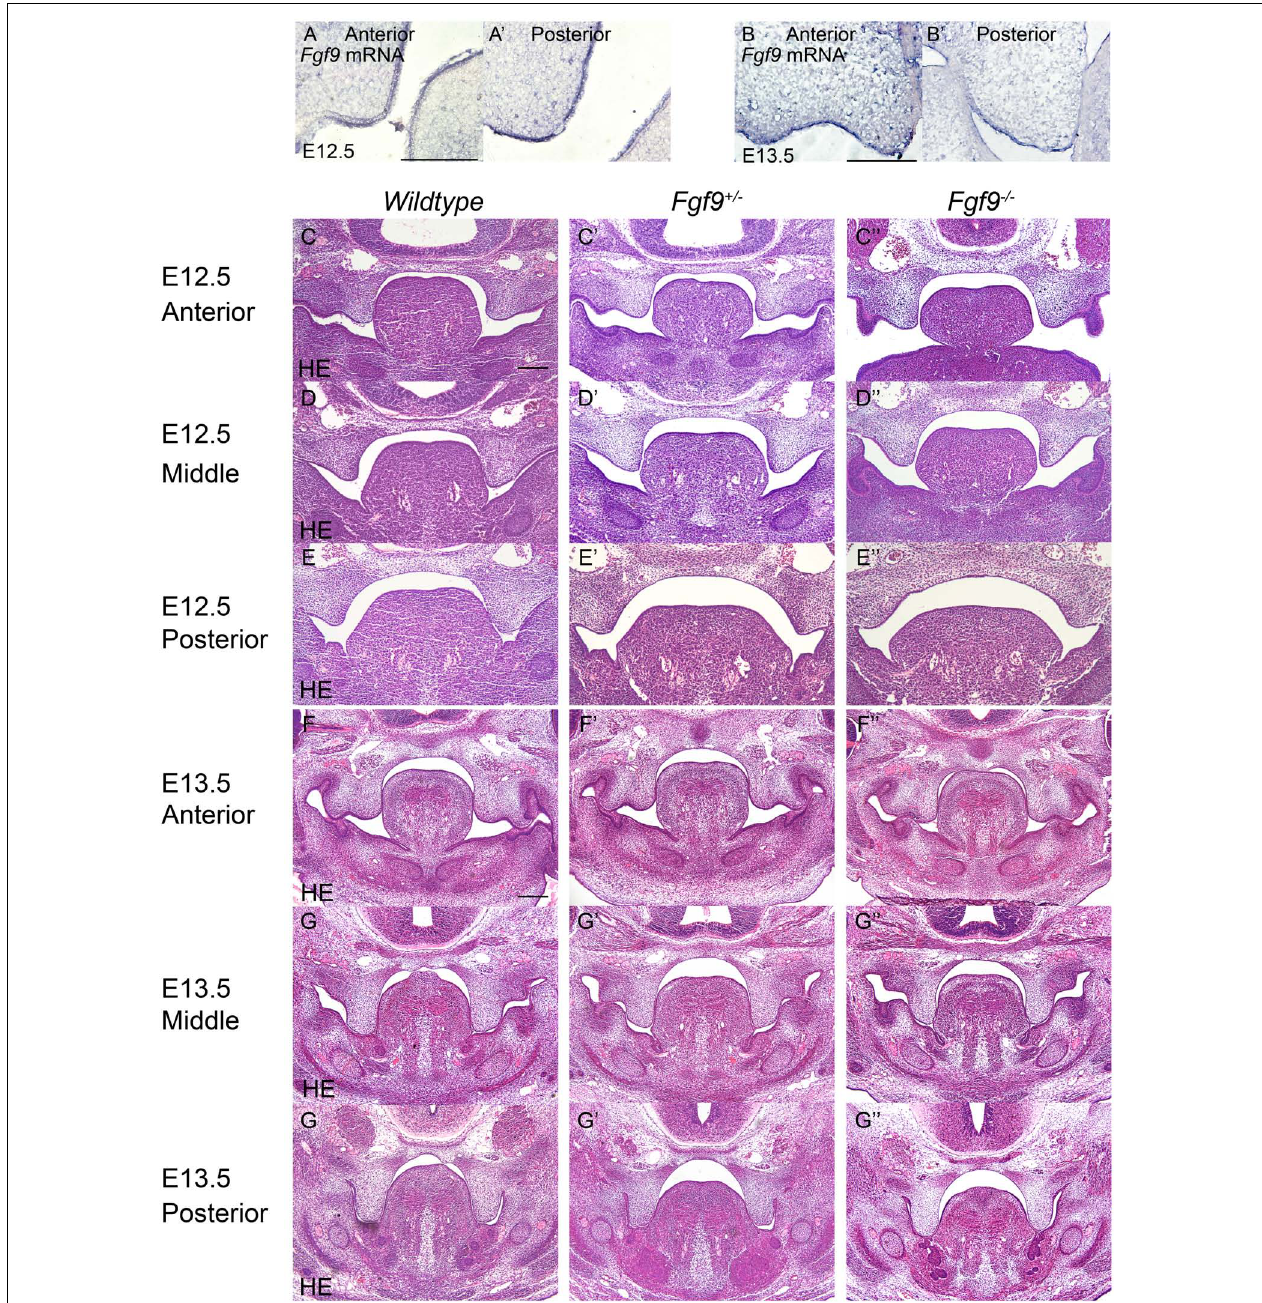
FIGURE 4 | Fgf9 expression and phenotypes of Wildtype , Fgf9 + / − , and Fgf9 − / − embryos at E12.5 and E13.5. Location of Fgf9 mRNA at E12.5 in (A) anterior and (A’) posterior palatal shelves, and at E13.5 in (B) anterior and (B’) posterior palatal shelves. Fgf9 − / − embryos exhibited no significant abnormalities at (C–E”) E12.5 and (D–G”) E13.5. Scale bars = 200 µ